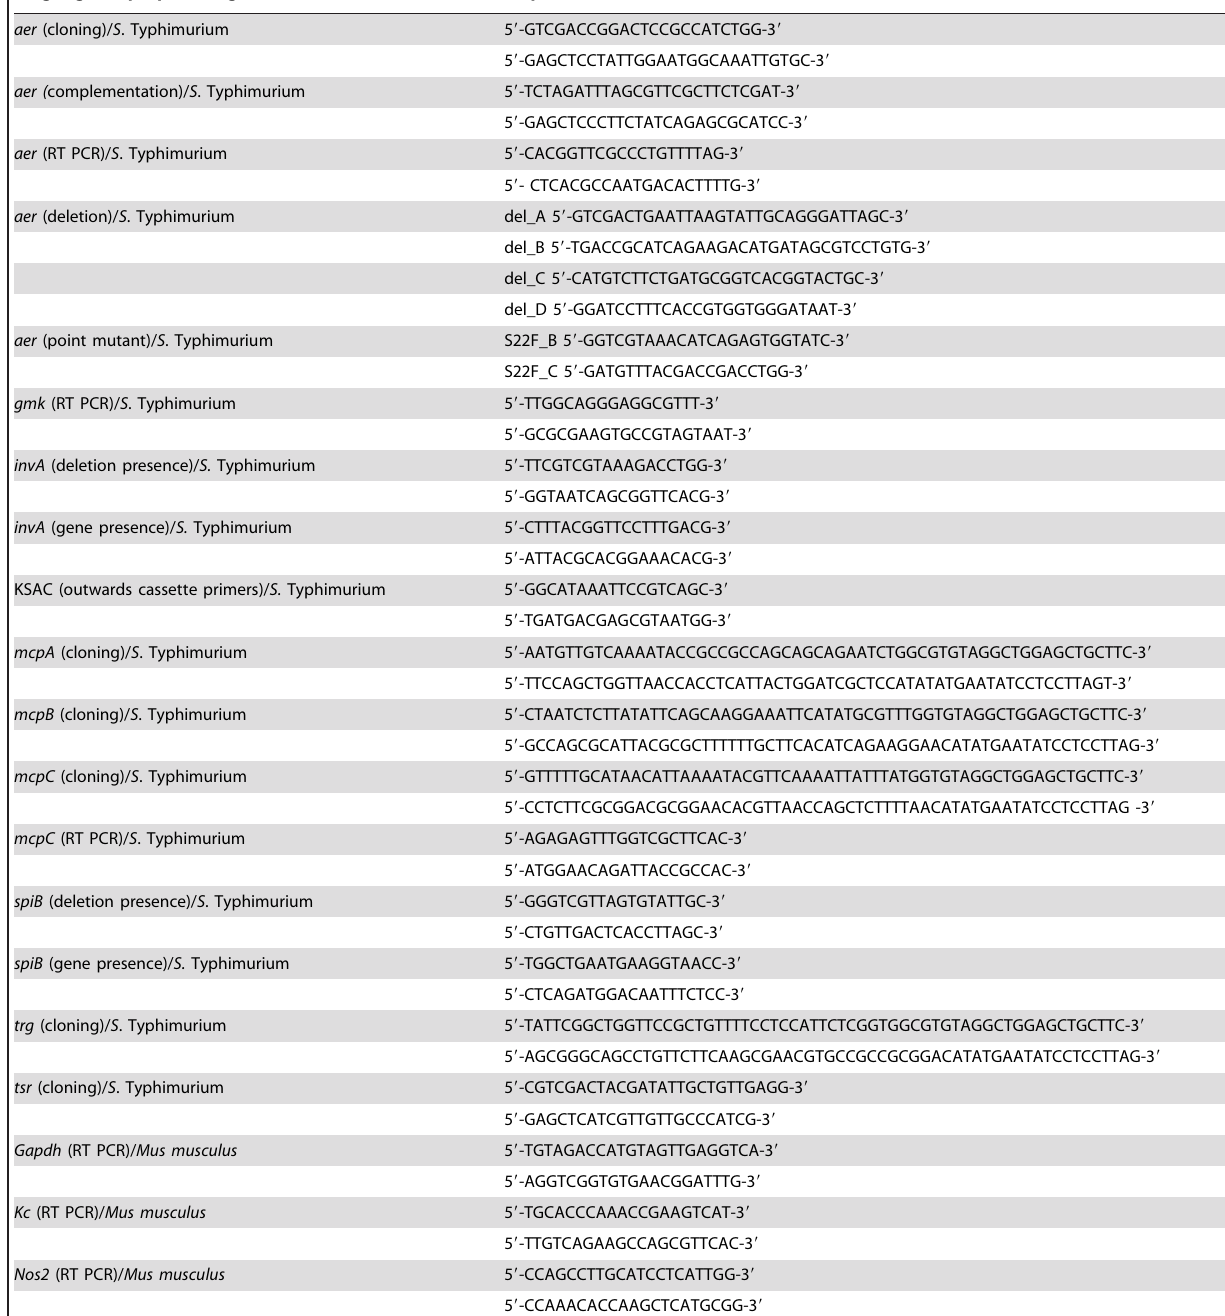
Table 3. Primers used in this